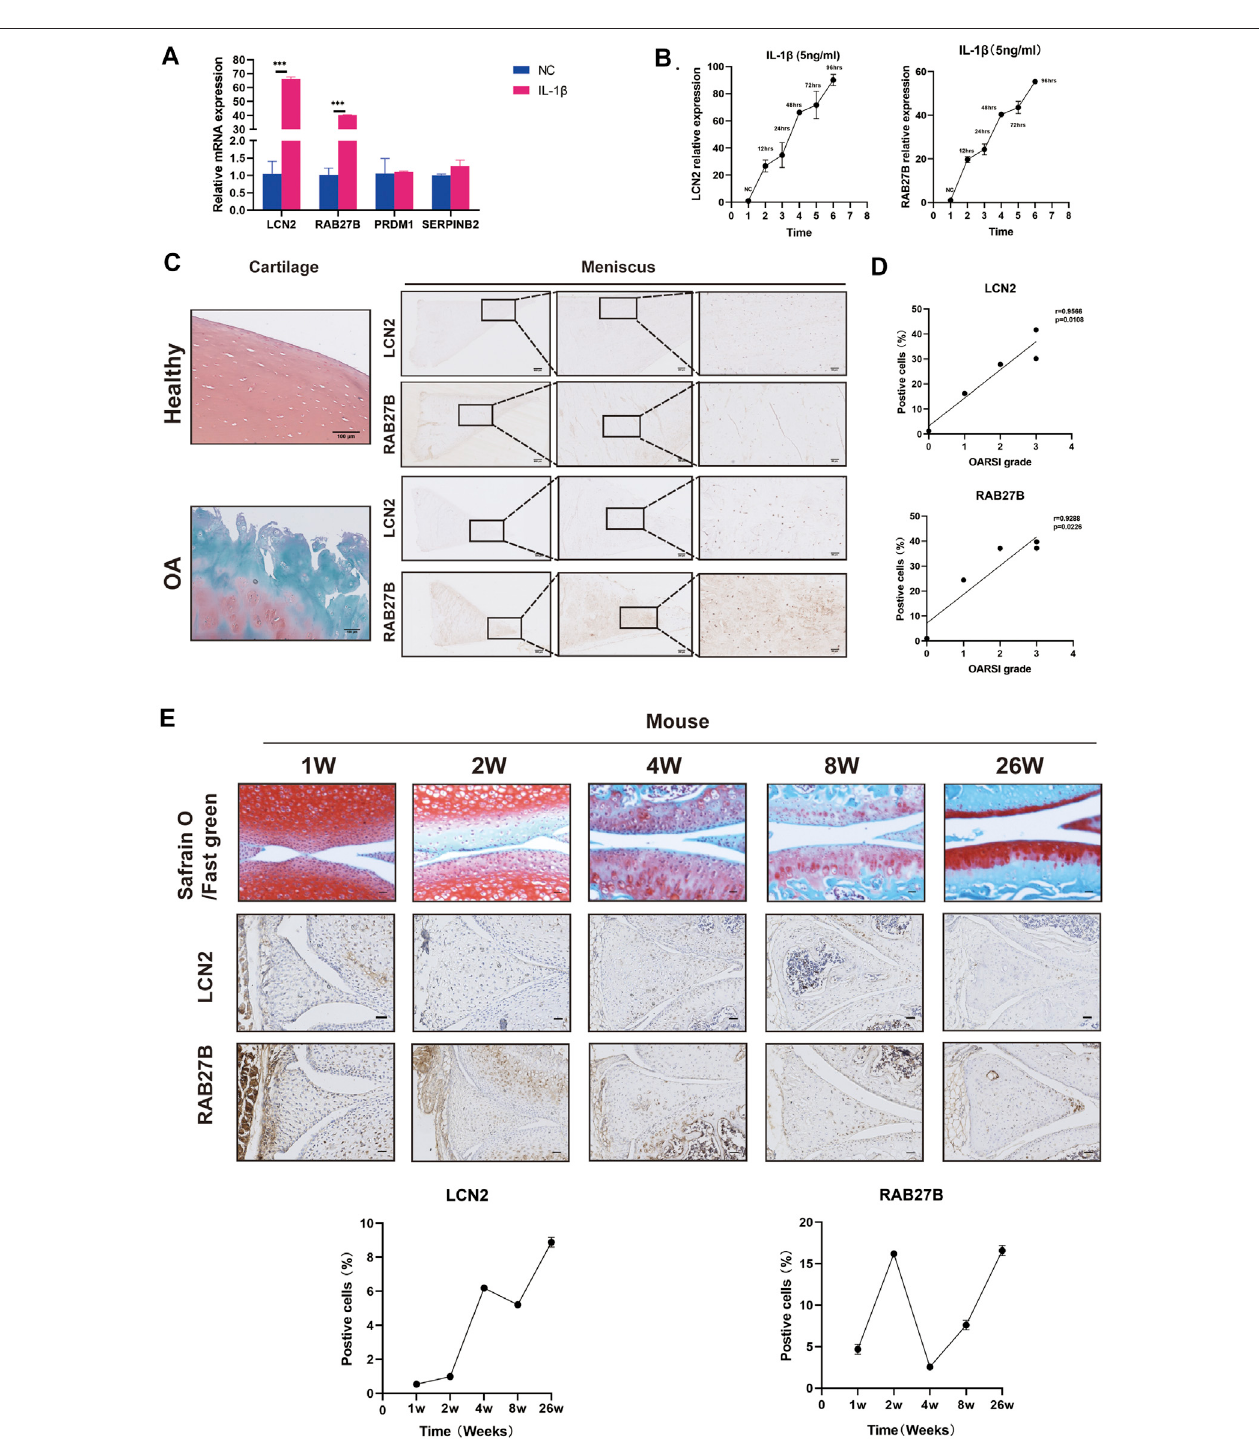
FIGURE 6 | LCN2 and RAB27B might act as biomarkers in the meniscus for early osteoarthritis (OA) diagnosis. (A) Relative expression levels of LCN2 , RAB27B , PRDM1 , and SERPINB2 in IL-1 β -treated menisci. GAPDH was used as the internal reference gene for qRT-PCR relative expression. Error bars reveal the standard deviation or the standard error of the data. The statistical methods are described above. * p < 0.05, ** p < 0.01, *** p < 0.001. (B) Relative expression levels of LCN2 and RAB27B in menisci treated with time-dependent IL-1 β stimulation (0, 12, 24, 48, 72, and 96 h). GAPDH was used as the internal reference gene for qRT-PCR relative expression. Error bars reveal the standard deviation or the standard error of the data. (C) Safranin O/Fast Green staining of patients ’ knee cartilage and immunohistochemical (IHC) staining of patients ’ menisci with antibody against LCN2 and RAB27B. (D) Correlation coef fi cient between LCN2 and RAB27B expression quanti fi ed byIHC positive cell percentage and OARSIscore in patients ’ samples ( n (cid:2) 5). (E) Safranin O and IHC staining of LCN2 and RAB27B in mice knee at 1, 2, 4, 8, and 26 weeks and quanti fi cation of positive cells ( n (cid:2) 3). Error bars reveal the standard deviation or the standard error of the data. Scale bar, 50 μ m.